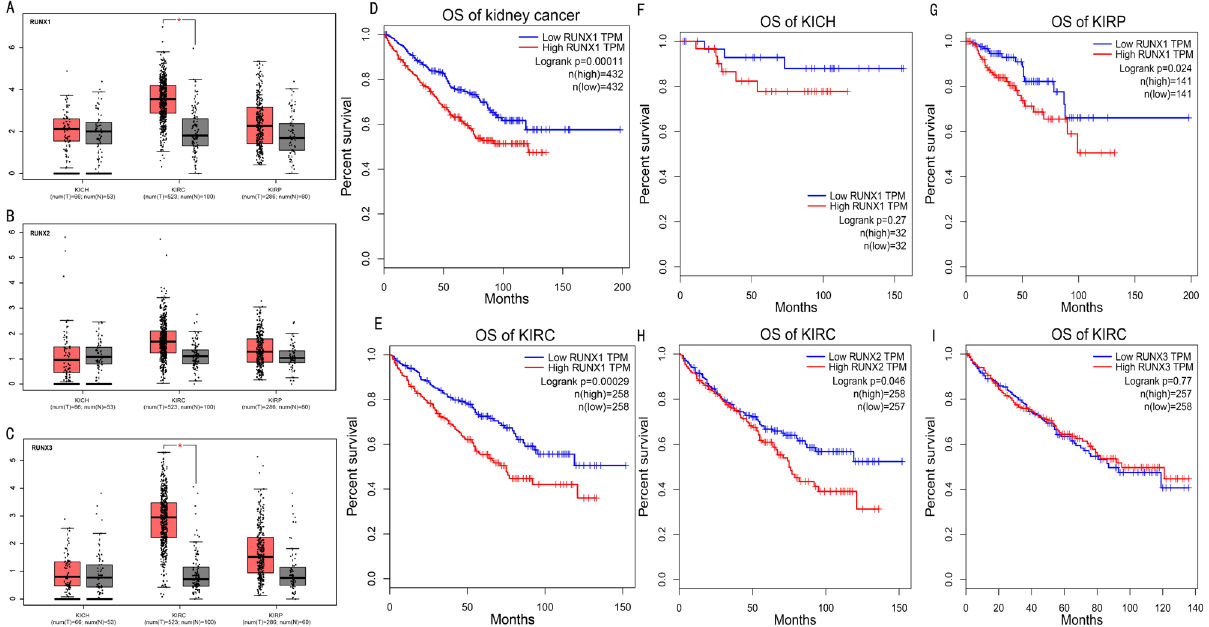
Figure 2. ( A – C ) GEPIA analysis results of the mRNA expression level of RUNX genes in different types of kidney cancer. Box plots of individual RUNX expression in KIRC tissues and paired normal tissues, *: p -value < 0.05. ( D – I ) Correlation analysis between RUNX1 , RUNX2 and RUNX3 expressions and overall survival in different types of kidney cancer patients by Kaplan–Meier plotter. KICH: kidney chromophobe renal cell